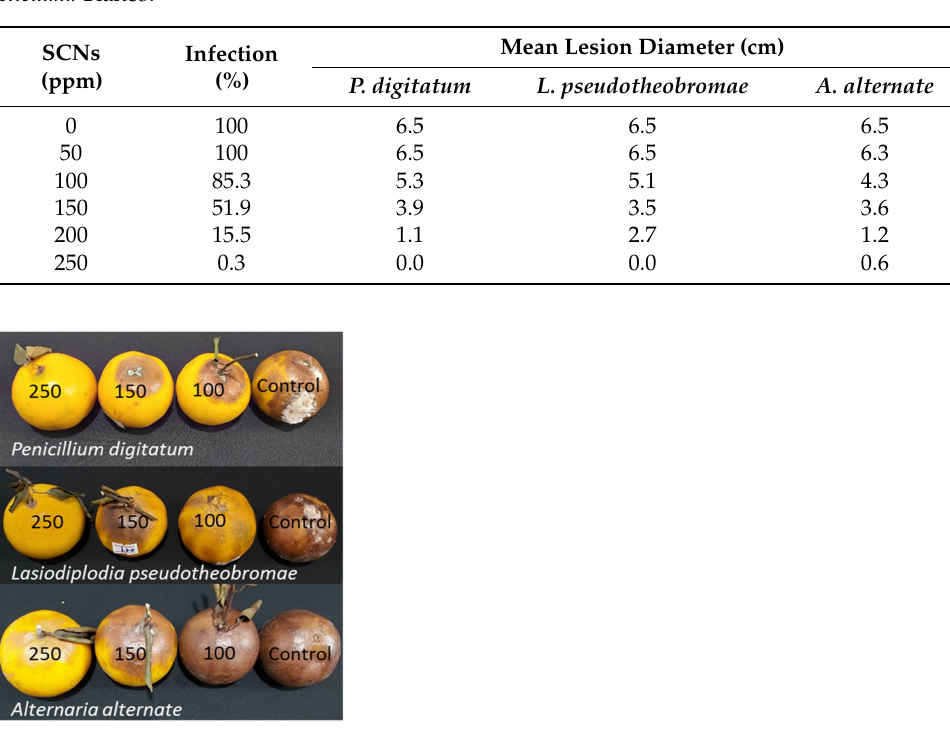
Table 3. The antifungal activity of SCNs at different concentrations against three fungi on Citrus reticulata Blanco.